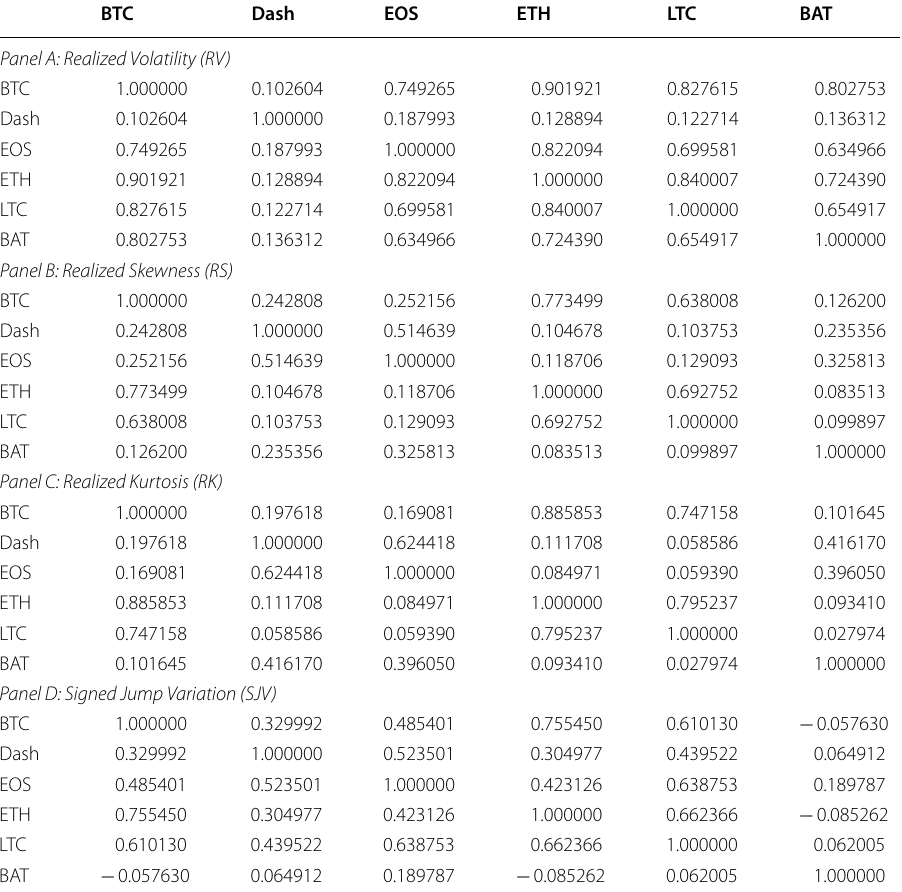
Table 2 Unconditional correlation matrix of daily realized moments BTC Dash